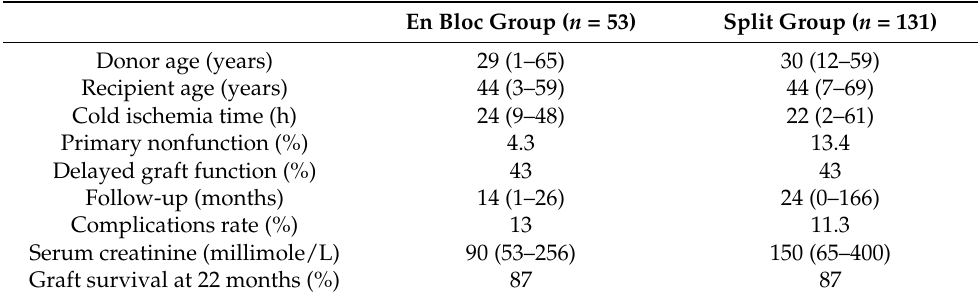
Table A1. Results of horseshoe kidney transplants. En bloc vs. split